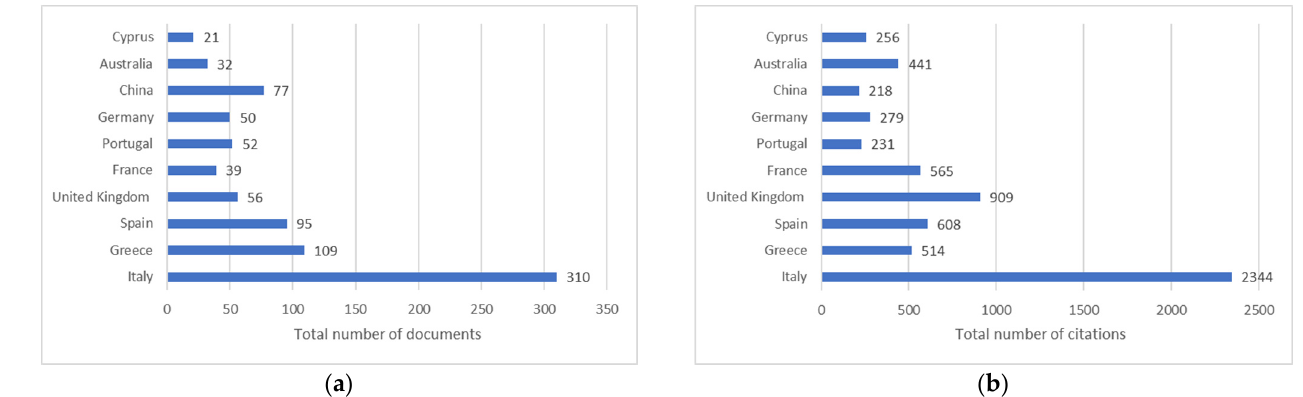
Figure 5. The 10 most active countries by number of documents ( a ) and citations ( b ).